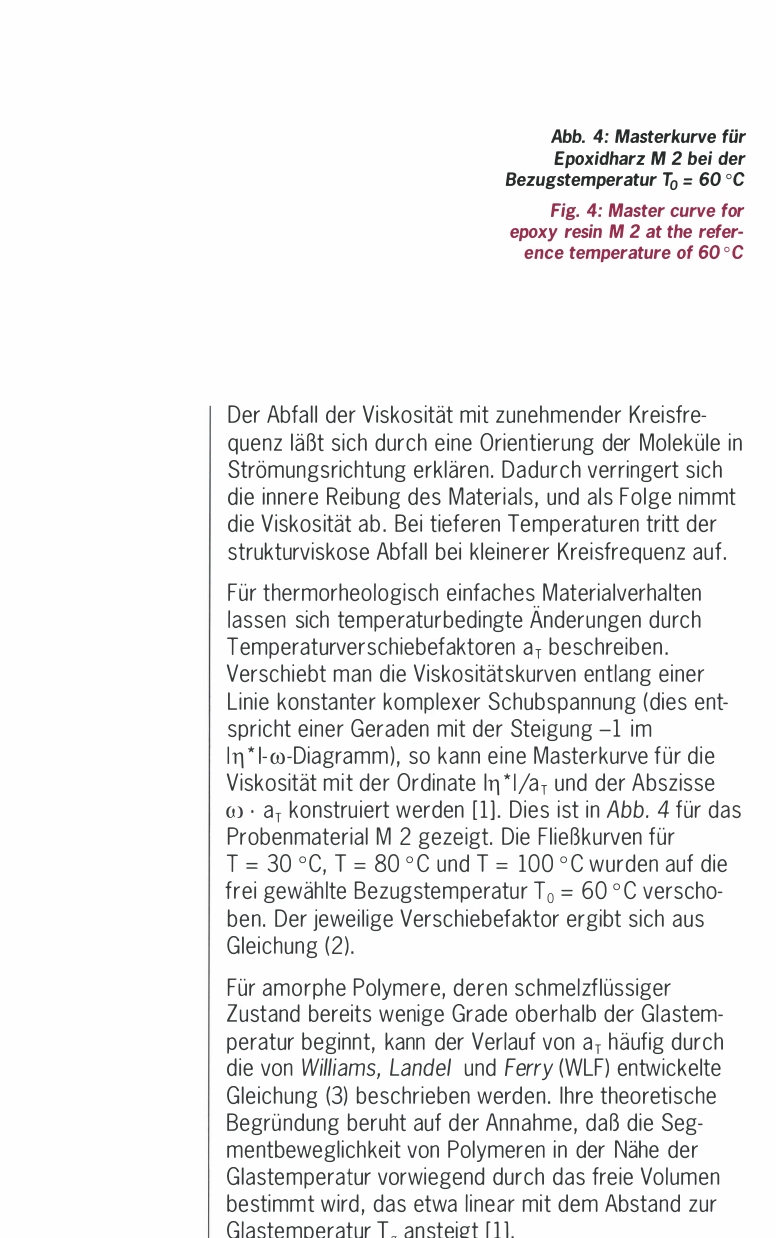
Fig. 5: Temperature depen- dence of the displacement factor a1 and description by the WLF equation